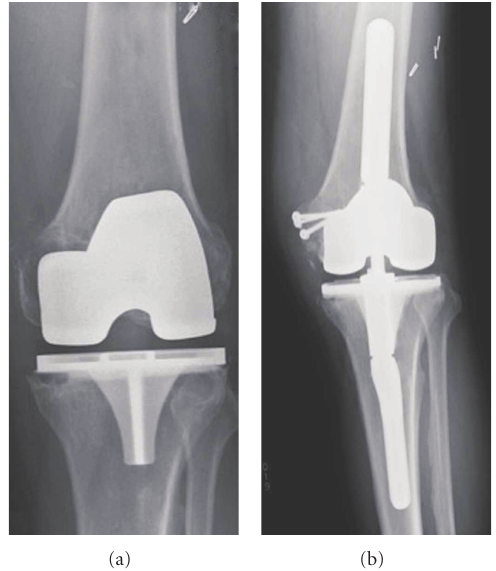
Figure 2: A radiograph shows uncontained bone loss in the medial femoral condyle secondary to osteolysis (a). A radiograph showing revision TKA with reconstruction of the medial femoral condyle using structural allograft fixed with screws